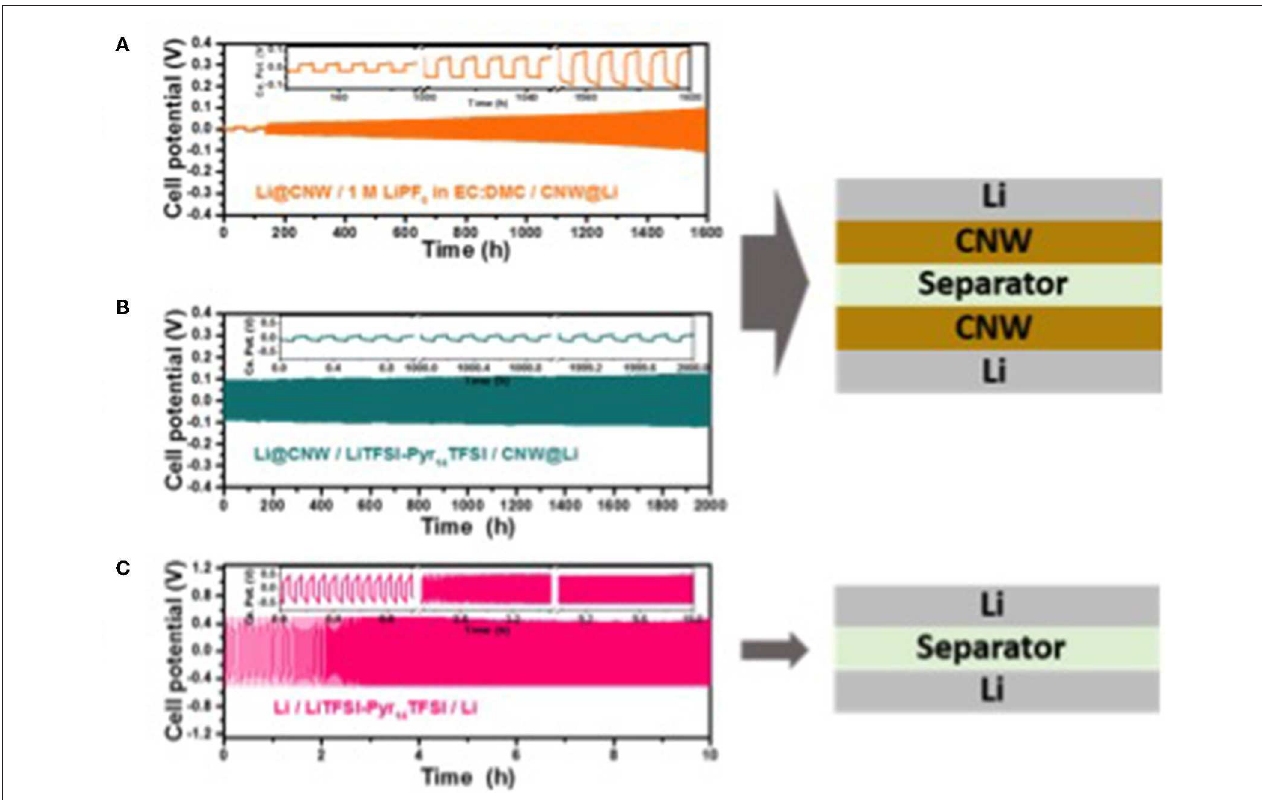
FIGURE 2 | Room temperature (20 ◦ C) galvanostatic plating/stripping experiments for three-electrode cells composed of two (A) Li@CNW electrodes with the organic electrolyte at 0.5mA